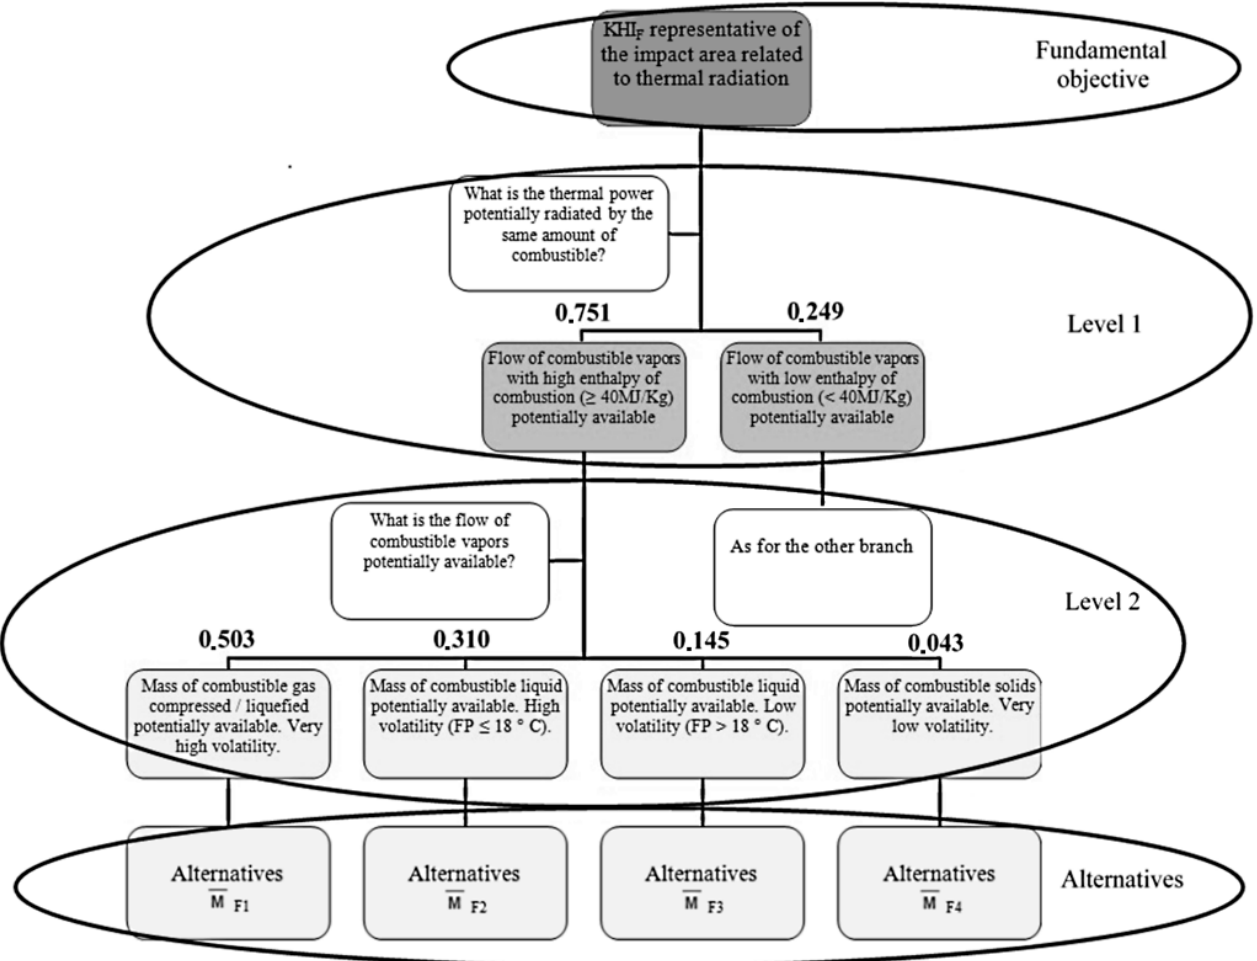
Fig. 1. Hierarchy used for flood-related Na-Tech qualitative risk analysis in case of fires. The weights assigned are shown along the different branches, while the related question to be answered is located above each